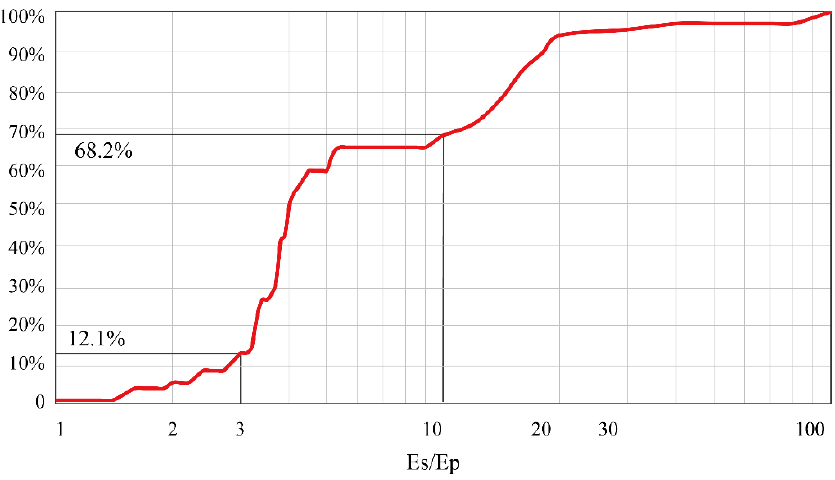
Figure 12. Distribution of the ES/EP value of MS events controlled by adverse geological structures.